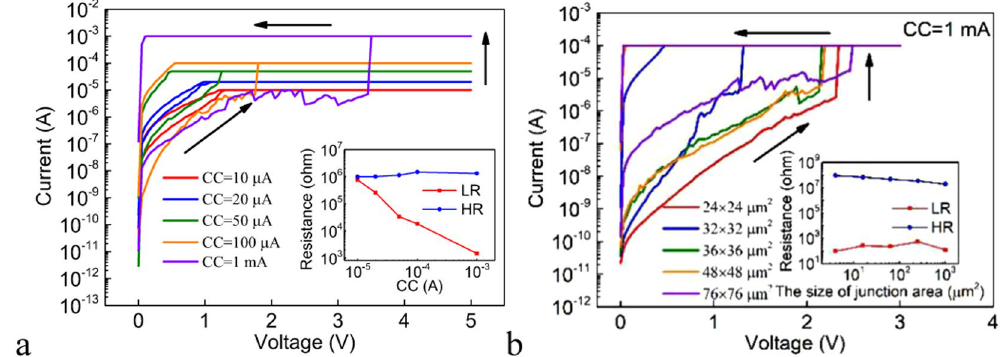
Figure 8. ( a ) The DC I-V curves under different SET CCs in the SET process for the Pt/GeS/Te cell. Inset: the dependence of the LR and HR on the CC. ( b ) The DC I-V curves under the SET CC of 1 mA in the SET process for Pt/GeS/Te cell devices with different sizes of the junction areas. Inset: the dependence of the LR and HR on the size of the junction area for the Pt/GeS/Te